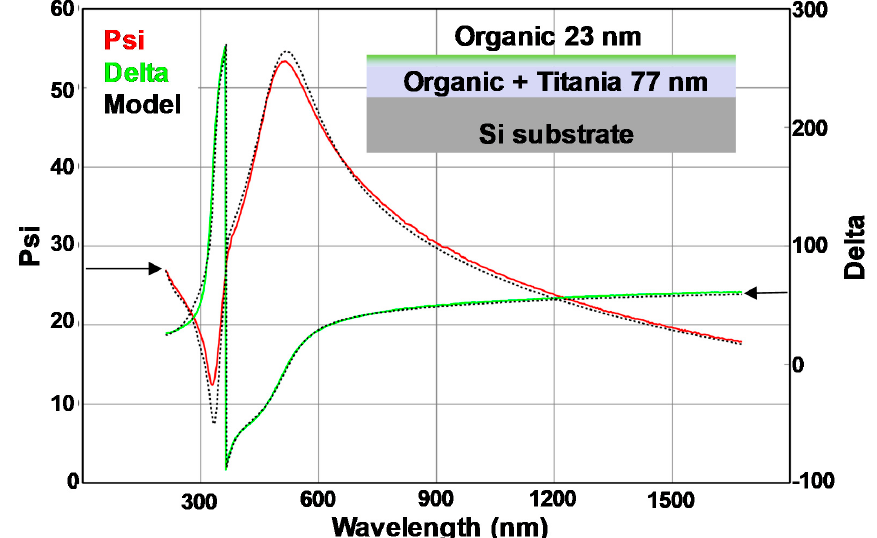
Figure 4. Ellipsometric analysis of an APhTS/TIPT condensed film obtained from sols with relative concentration of 1:40 (OrgSil:Ti-alk). Continuous lines correspond to the Psi and Delta ellipsometric parameters and dotted lines correspond to the model, with fitted thickness illustrated in the inset structure.